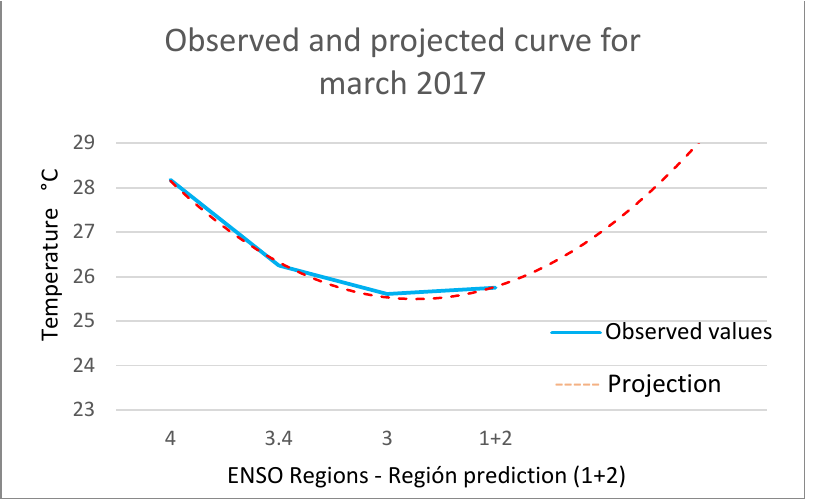
Figure 12. Example of the SST projection for zone 1 + 2 (Niño Costero) for the month of March.